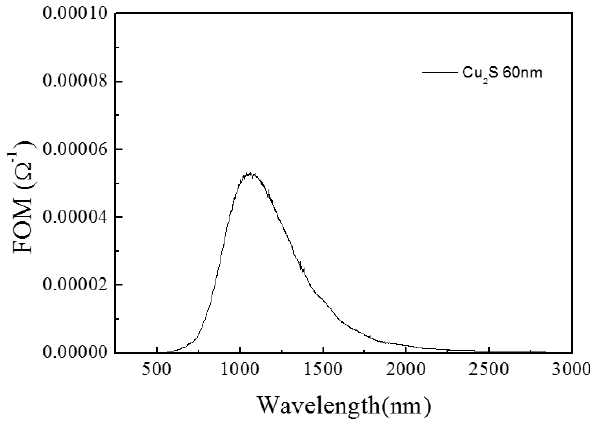
Figure 6. The figure of merit of Cu 2 S/glass complex films for different thickness.